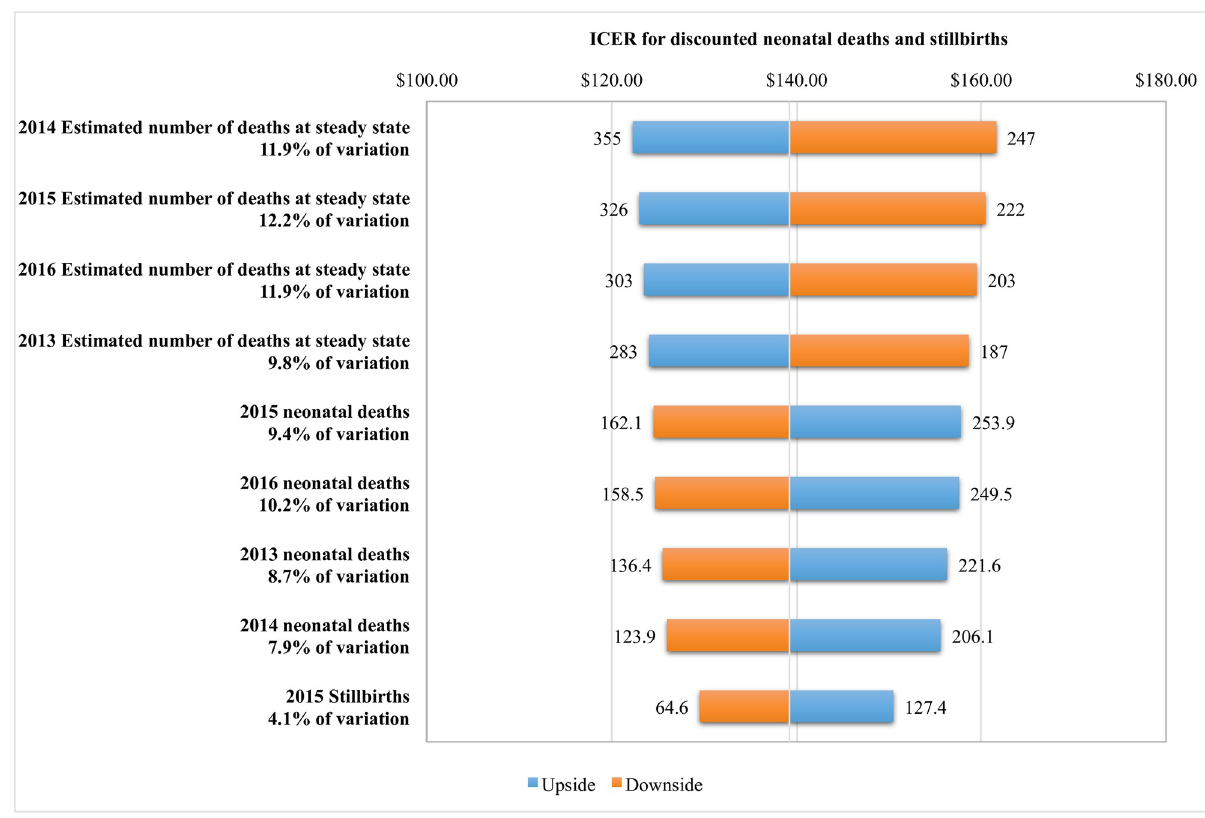
Fig 3. Tornado chart of ICER for discounted calculations of neonatal deaths and stillbirths estimated from steady-state assumption showing variables contributing � 4% of the variation in the estimates. ICER—incremental cost-effectiveness ratio; upside—assumption makes the intervention more cost effective; downside—assumption makes the intervention less cost